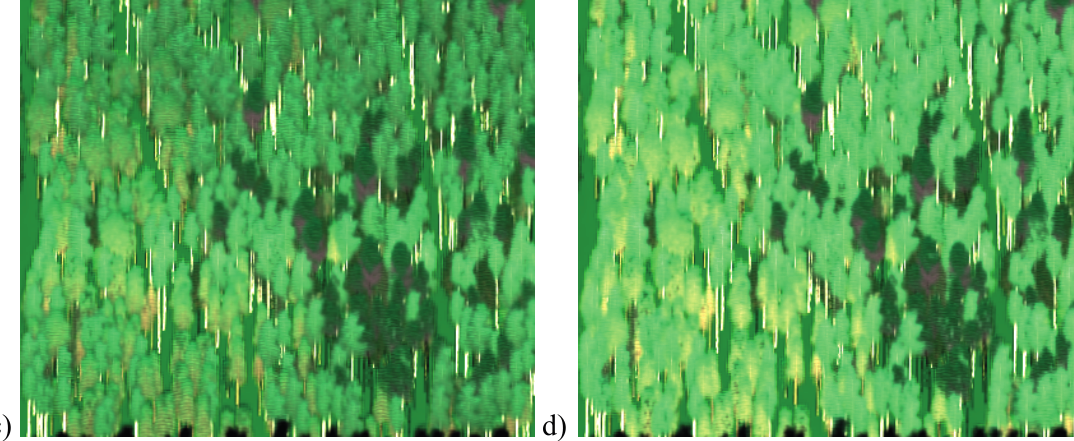
Figure 16. The changing hotspot perception simulated for the Jarvselja birth forest stand (Estonia) in summer: ( a ) DART simulated BRF for three spectral bands (442 nm, 551 nm, 661 nm), with SKYL equal to 0.21, 0.15 and 0.12, respectively, and DART simulated images for an airborne scanner flown at three altitudes: ( b ) 0.2 km, ( c ) 2 km and ( d ) 5 km, with ground resolution of 0.5 m. Dark zones in ( c ) and (d) correspond with occurrences of few pine trees in the birch